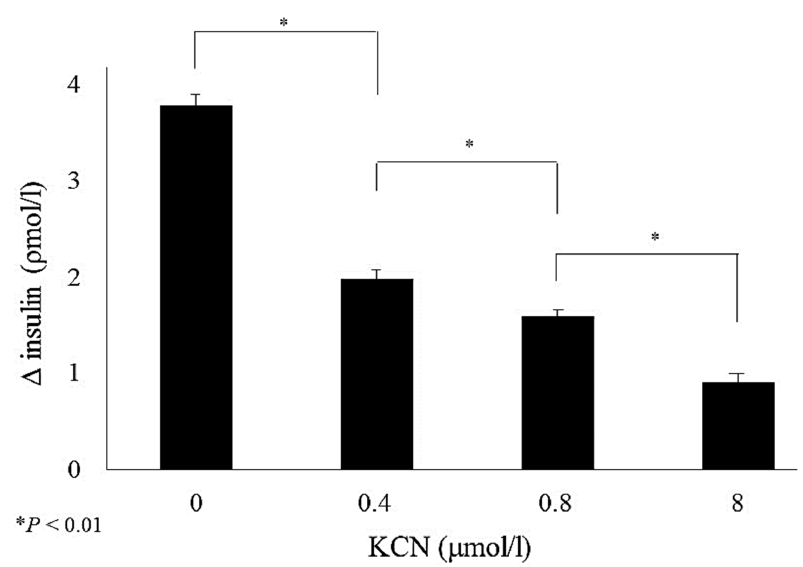
Figure 10. Glucose-stimulated insulin secretion of islets isolated from control rats fed a regular diet and incubated for 1 h with either 0, 0.4, 0.8, or 8 mol/L potassium cyanide (KCN) in the presence of 1.7 (baseline) or 16.7 mmol/L (stimulatory) glucose. The figure expresses insulin secretions measured as insulin secreted under stimulatory glucose minus insulin secreted under baseline glucose concentrations per islet of insulin content. Data are means ± SE for at least three separate experiments, * p < 0.01. Figure is used from [45] with permission from the publisher.